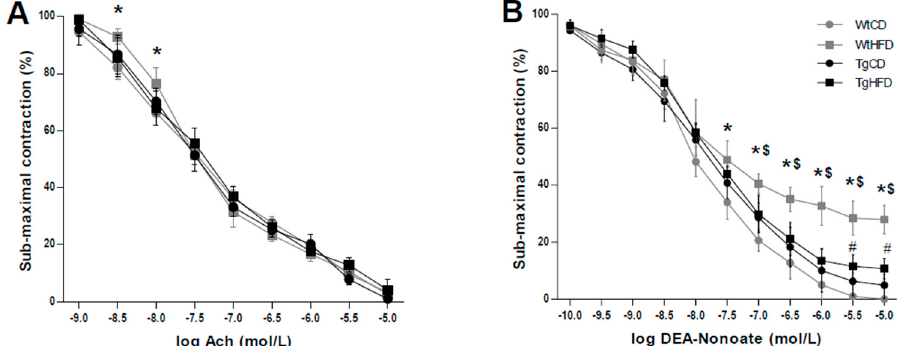
Figure 1. ( A ) Concentration-response curves to acetylcholine in wild type (Wt) and transgenic mice (Tg) overexpressing unacylated ghrelin fed a control (CD) or a high-fat diet (HFD). Vascular reactivity studies were performed on aortic segments from each group. * p ≤ 0.05 WtHFD vs. WtCD. n = 7 animals/group. Contractions to phenylephrine were similar among the experimental groups. ( B ) Concentration-response curves to DEA-NONOate in the same groups. * p ≤ 0.05 vs. WtCD. $ p < 0.05 TgHFD vs. WtHFD. # p < 0.05 TgHFD vs. WtCD. Contractions to phenylephrine were not significantly different in the four groups. n = 7 animals/group.